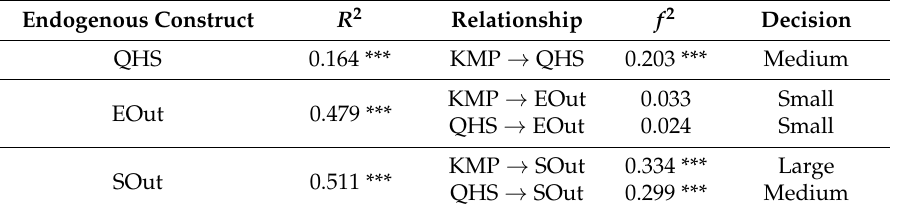
Table 4. Coefficient of determination ( R 2 ) values of the endogenous constructs and effect size ( f 2